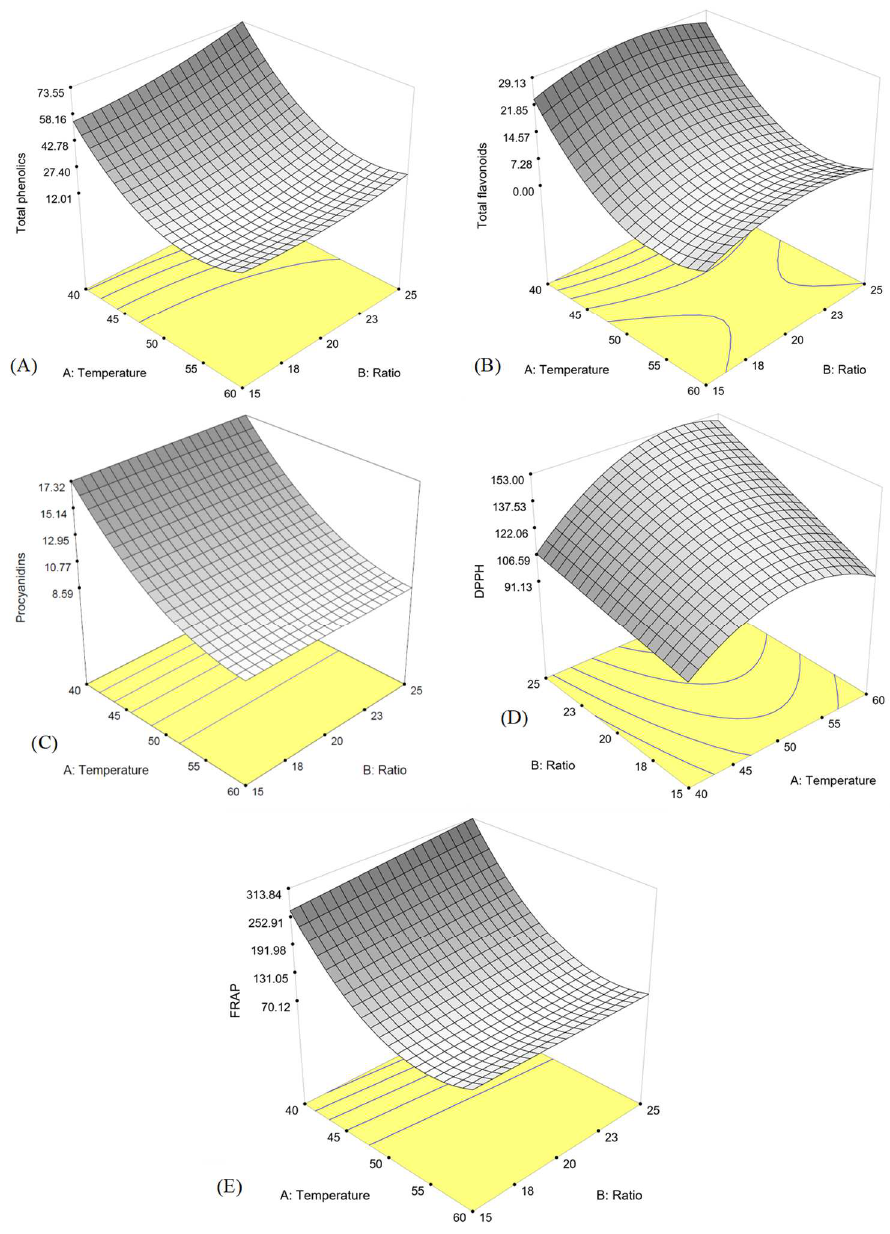
Figure 1. Response surface plot of ( A ) TPC, ( B ) TFC, ( C ) procyanidins, ( D ) DPPH and ( E ) FRAP as a function of extraction temperature and solvent-to-solid ratio.